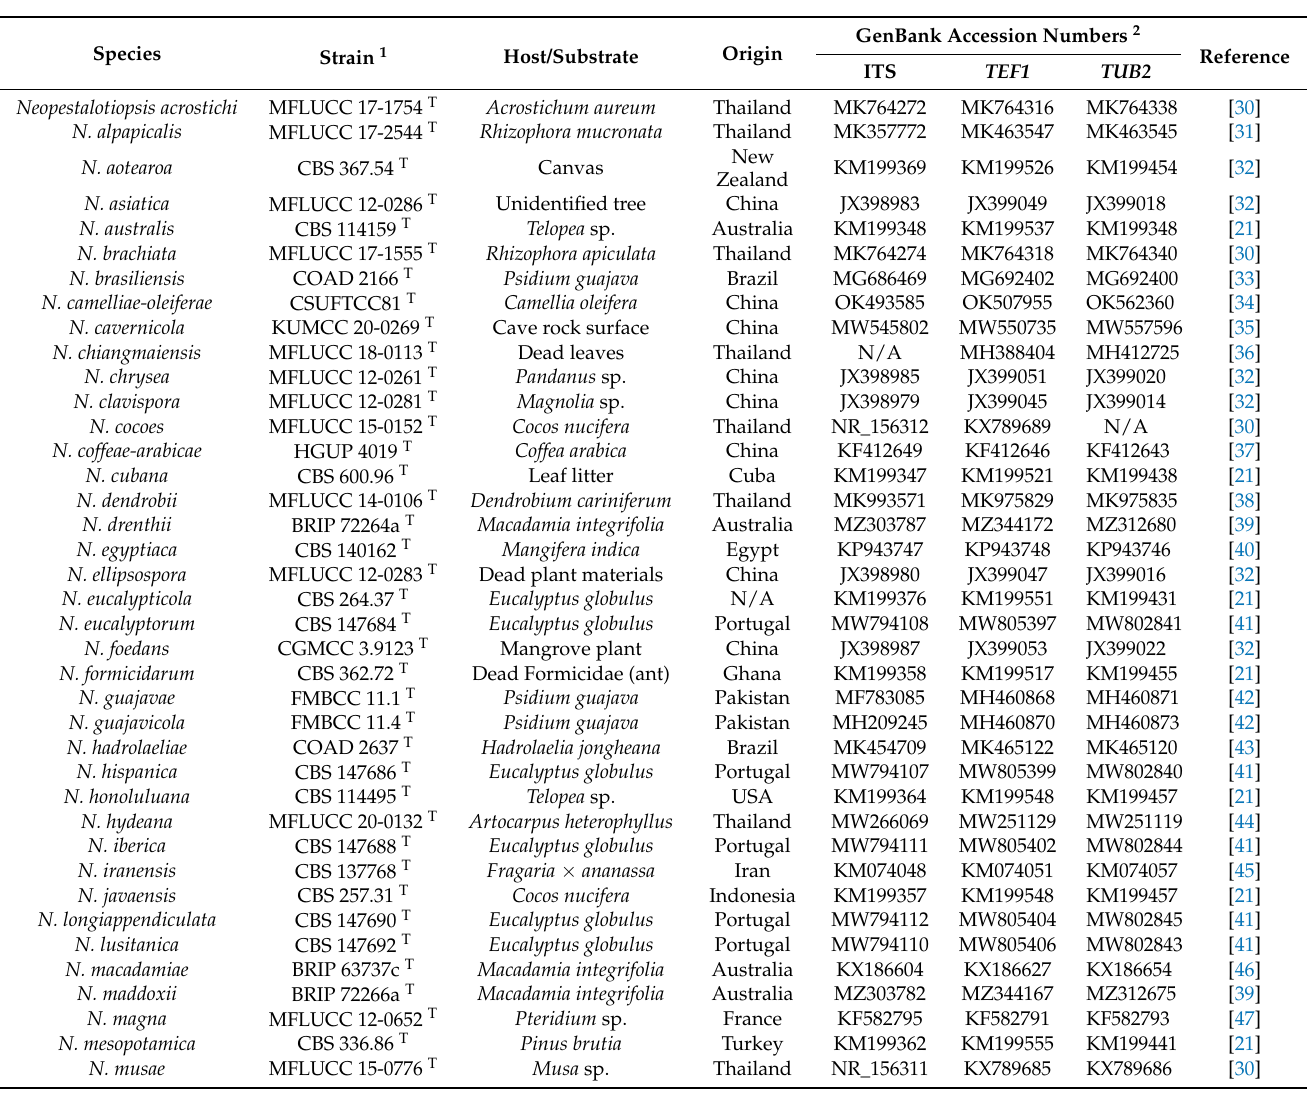
Table 1. Information of fungal isolates used in the phylogenetic analysis and their corresponding GenBank accession numbers. Isolates in bold are from this